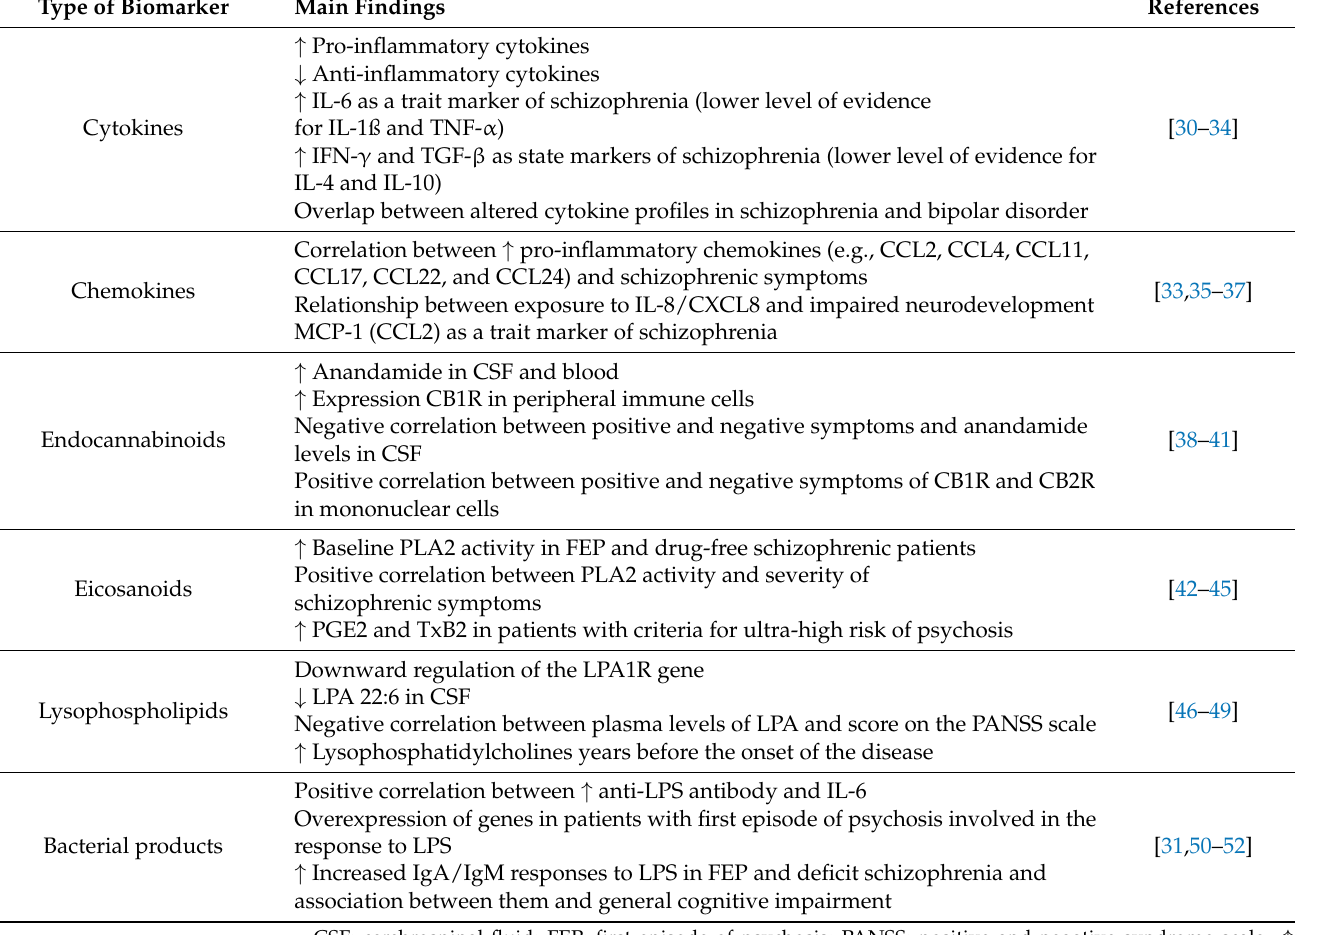
Table 3. Immuno-inflammatory markers in psychotic spectrum